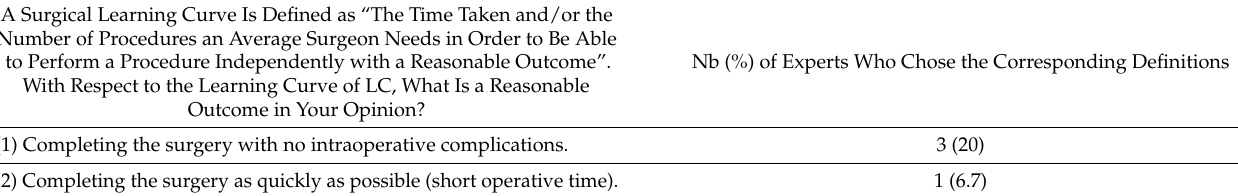
Table 1. Definition of learning curve.